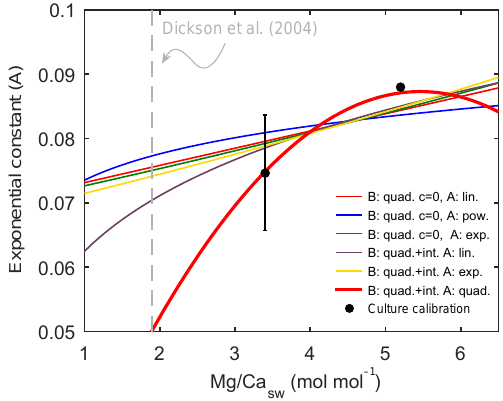
Figure 5. Variation in the sensitivity of the G. ruber Mg / Ca ther- mometer with seawater Mg / Ca, for a range of assumptions re- garding the relationship between Mg / Ca sw and the coefficients of a Mg / Ca–temperature calibration of the form Mg / Ca = B exp AT . Data points are based on the cultures of Kisakürek et al. (2008, mod- ern seawater) and Evans et al. (2016, Mg / Ca sw = 3 . 4molmol − 1 ). Lines are derived from least-squares modelling of these data sets as well as the seawater-shell Mg / Ca calibration of Evans et al. (2016). A range of model curves are shown based on different assump- tions of the form the regression between the exponential coefficient of a Mg / Ca–temperature calibration and Mg / Ca sw should take, shown in the legend. For example, the thick red line assumes that both coefficients of a Mg / Ca–temperature equation vary quadrati- cally with Mg / Ca sw ; the blue line assumes that the pre-exponential coefficient varies quadratically whilst the exponential coefficient varies with a power function with respect to Mg / Ca sw . “quad. c = 0” are quadratic equations forced through the origin, whilst “quad.+int.” are quadratic regressions with a y intercept. An es- timate of early Eocene Mg / Ca sw (Dickson, 2004) is shown for comparison. These models suggest that the exponential coefficient of a Mg / Ca–temperature calibration may be reduced from 0.09 to 0.05–0.075 at this